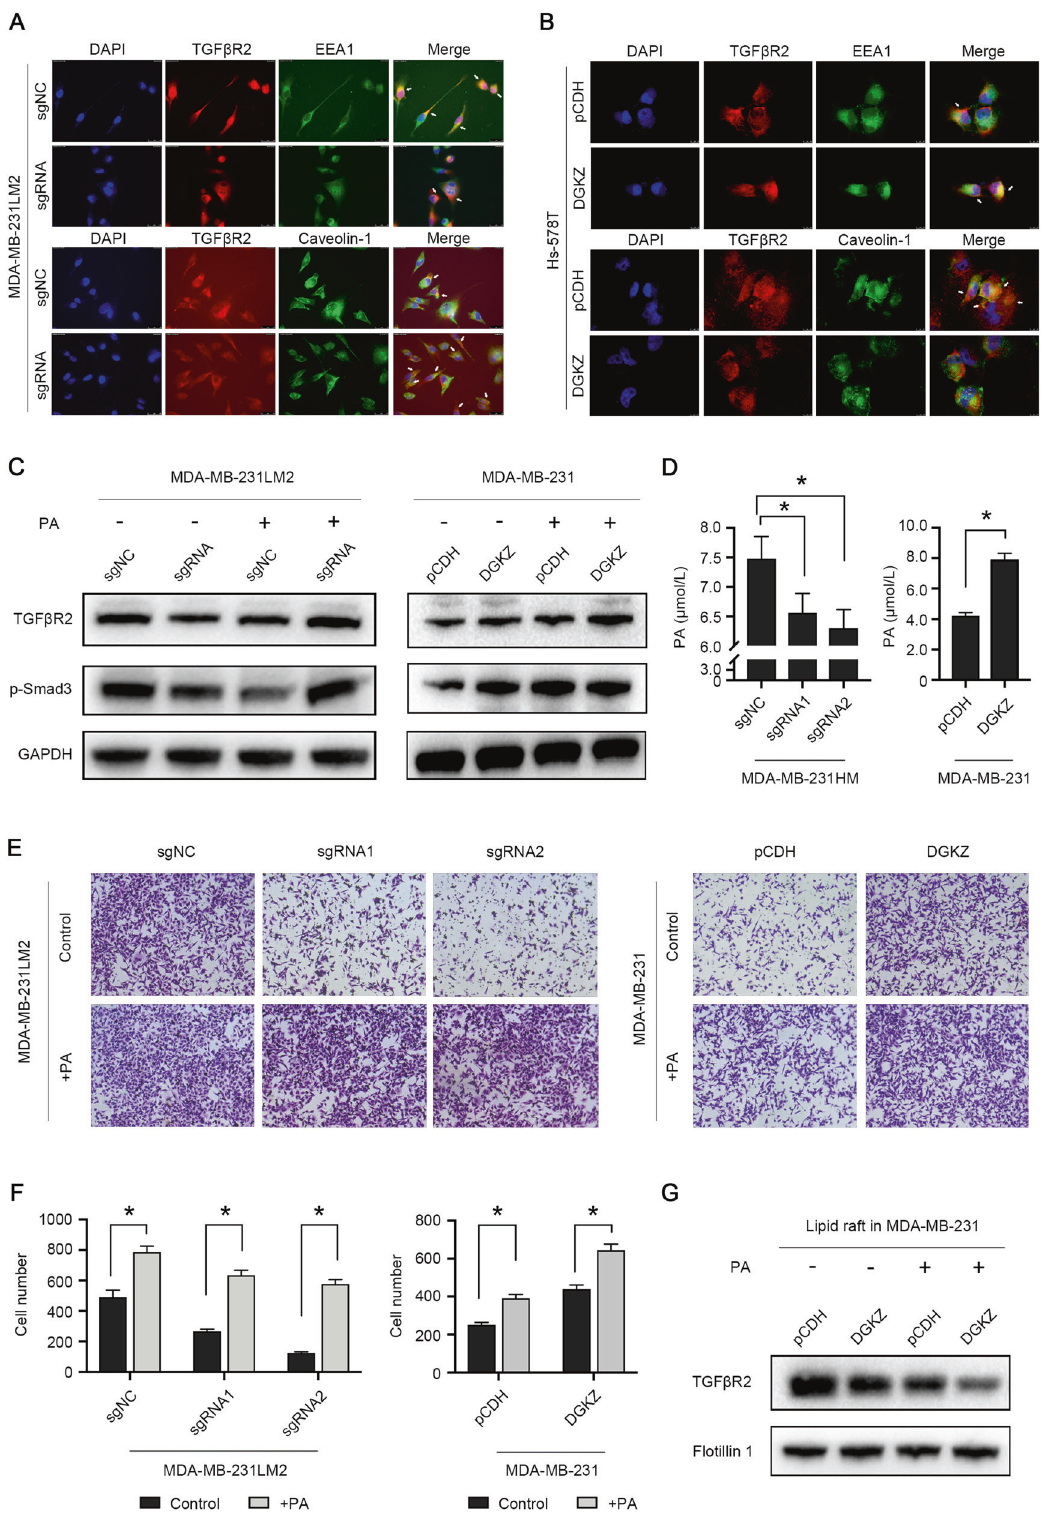
mouse breast cancer models. TMAs of samples from breast cancer patients revealed that high DGKZ expression correlated with poor prognosis. Our results suggest that further studies should be established to fi nd the potential clinical utility of DGKZ as a prognostic biomarker for aggressive breast